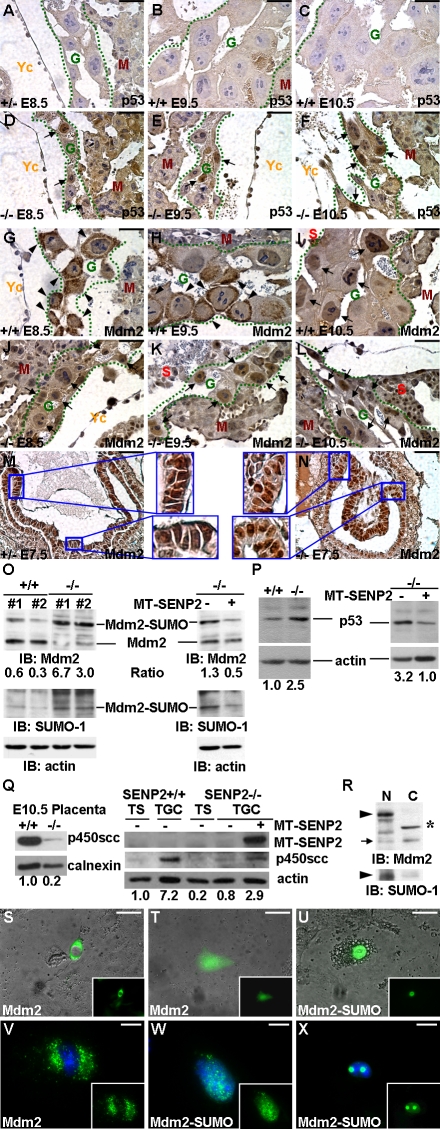
SENP2 Regulates the p53–Mdm2 Circuit During Trophoblast Development(A–N) Sections of the E7.5 (M,N), E8.5 (A,D,G,J), E9.5 (B,E,H,K) and E10.5 (C,F,I,L) SENP2+/+ or SENP2+/– (A–C,G–I,M) and SENP2–/– (D–F,J–L,N) placentas were stained with an anti-p53 (A–F) or anti-Mdm2 antibody (G–N). The stained (brown) sections were counterstained with hematoxylin (blue).(D–F) Nuclear accumulations of p53 (arrows) were detected in the SENP2 mutants.(G–I) In the SENP2+/+ TGCs, Mdm2 predominantly accumulated in the cytoplasm at E8.5 and E9.5 (arrowheads; G,H), but in the nucleus at E10.5 (arrows; I).(J–L) Nuclear accumulations of Mdm2 were found throughout the SENP2–/– TGC development at E8.5–E10.5 (arrows; J,K,L). The TGC layers are defined by broken green lines.(M,N) Mdm2 showed clear nuclear localizations in the SENP2–/– trophoblast progenitors at the niche sites (N), whereas it was evenly distributed in the controls (M). Enlargements of the insets are shown.(O) SUMO modification of Mdm2 is regulated by SENP2. Immunoblot analysis with anti-Mdm2 and anti-SUMO-1 antibodies shows that Mdm2 accumulated in its sumoylated state (Mdm2–SUMO) in the SENP2–/– trophoblast cells. Two different cell lines (#1 and #2) were examined. The Mdm2–SUMO band could also be detected by immunoprecipitation–immunoblot with anti-Mdm2 and anti-SUMO-1 antibodies (data not shown). Reintroduction of SENP2 into the SENP2–/– TS cells diminished the Mdm2–SUMO level. Actin level also was analyzed as a loading control. The number indicates the ratio of Mdm2–SUMO and Mdm2.(P) The p53 protein level is regulated by SENP2. Protein lysates were isolated from the SENP2+/+ and SENP2–/– TS cells with or without transfection of MT–SENP2. Immunoblot analysis with an anti-p53 antibody revealed the steady state levels of p53 and actin (loading control). Inactivation of SENP2 induced an accumulation of p53 in trophoblasts. Reintroduction of SENP2 down regulated p53 in the SENP2-null mutants. The number represents the expression level of p53 in SENP2–/– relative to that in SENP2+/+.(Q) SENP2 is necessary and sufficient to induce trophoblast differentiation. Protein lysates were isolated from the SENP2+/+ and SENP2–/– placentas at E10.5, and the SENP2+/+ and SENP2–/– TS cells with or without transfection of MT–SENP2. The TS cells were cultured in differentiation media for 6 d to obtain the differentiated TGCs. Immunoblot analysis with an antibody that recognizes either p450scc or MT revealed the steady state protein level. The levels of ER protein calnexin and actin were analyzed as loading controls. The number shows the quantitative difference in p450scc expression.(R) Preferential accumulations of Mdm2 (arrow) and Mdm2–SUMO (arrowheads) in TS cells. Nuclear (N) and cytoplasmic (C) extracts of SENP2–/– were analyzed by immunoblot with anti-Mdm2 and anti-SUMO-1 antibodies. Asterisk indicates non specific reaction detected after cell fractionation.(S–X) Mdm2 and Mdm2–SUMO are differentially localized in the cell. TS cells transfected by the GFP-tagged Mdm2 (S,T,V) or Mdm2–SUMO-1 fusion (U,W,X) under control of a CMV promoter were analyzed by GFP analysis with either phase contrast (S–U) or by immunofluorescence microscopy (blue, DAPI) (V–X).G, TGC layer; M, maternal decidua; S, spongiotrophoblast layer; Yc, yolk sac cavity. Scale bars, 50 μm (A–N,S–U); 20 μm (V–X).